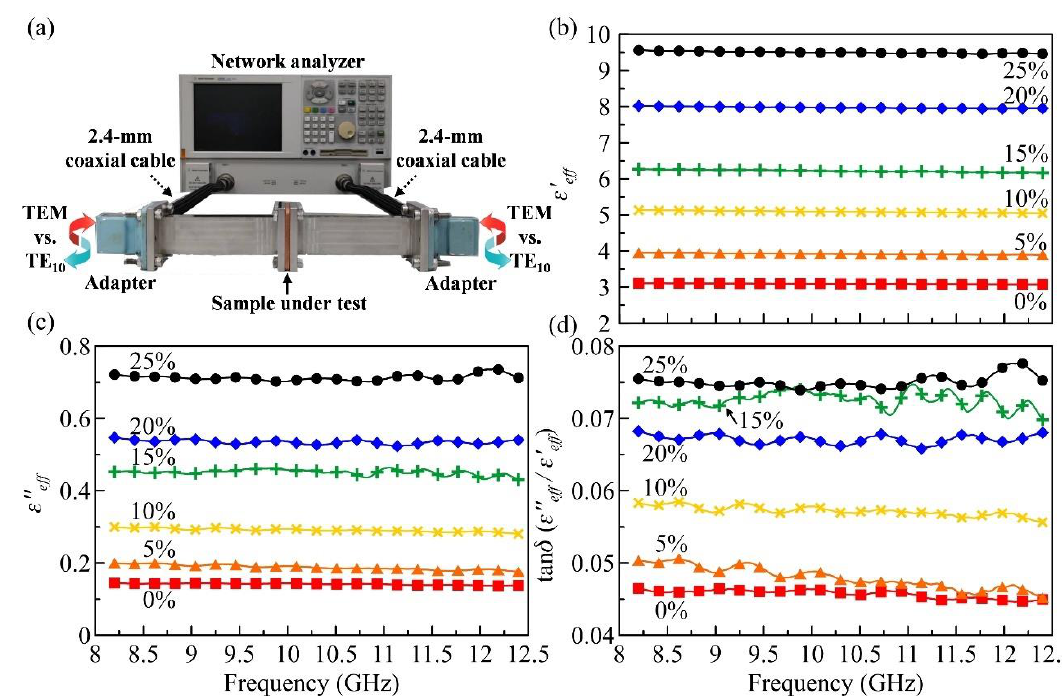
Figure 3. ( a ) Experimental setup for microwave permittivity characterization. Frequency dependence of ( b ) ε (cid:48) ef f , ( c ) ε (cid:48)(cid:48) ef f and ( d ) tan δ of BaTiO 3 –epoxy nanocomposites with six different volume fractions. Figure 3b,c demonstrate the retrieved ε (cid:48) ef f and ε (cid:48)(cid:48) ef f of six samples,